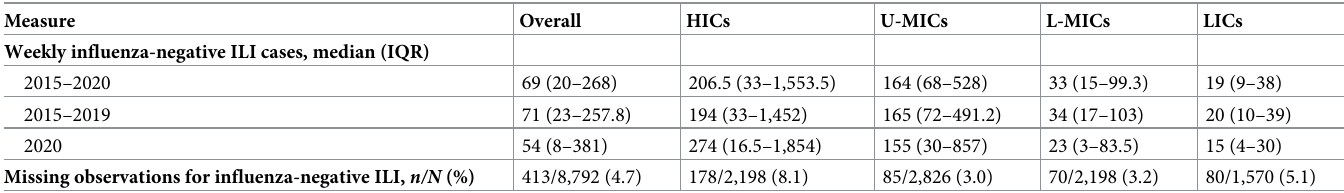
Missing observations for influenza-negative ILI, n/N (%) HICs, high-income countries; ILI, influenza-like illness; IQR, interquartile range; L-MICs, lower-middle-income countries; LICs, low-income countries; U-MICs, upper-middle-income